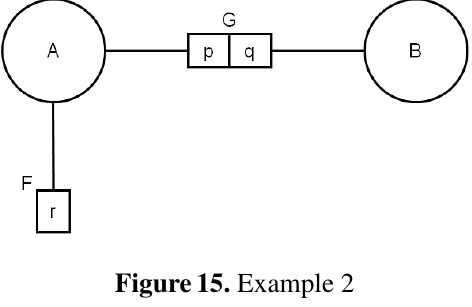
Figure 15. Example